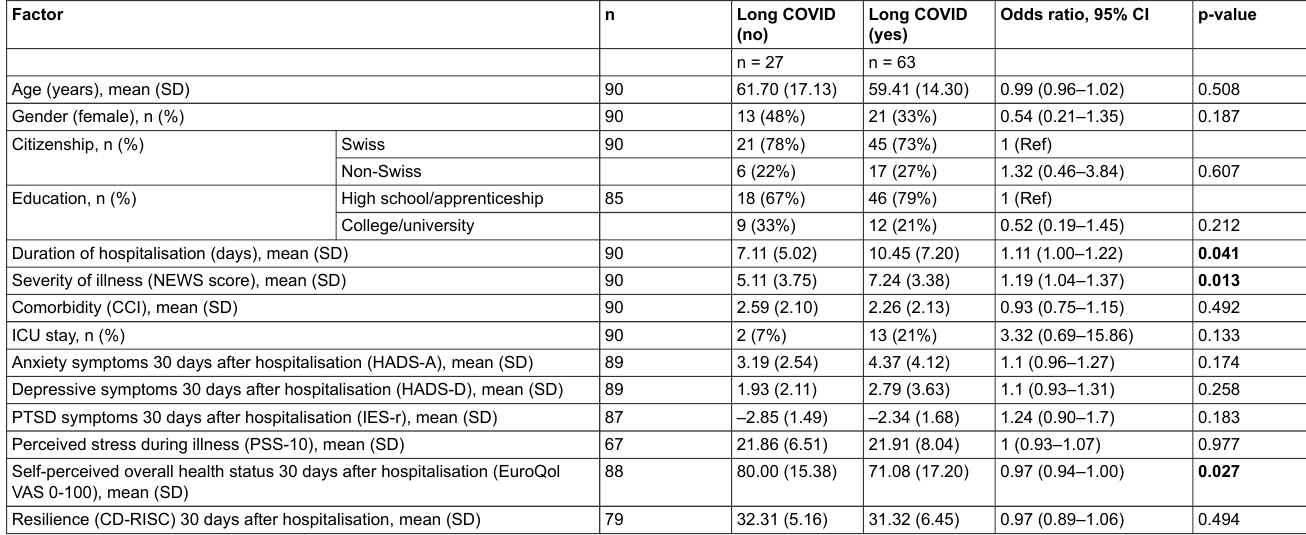
Table 2: Prevalence and factors associated with long